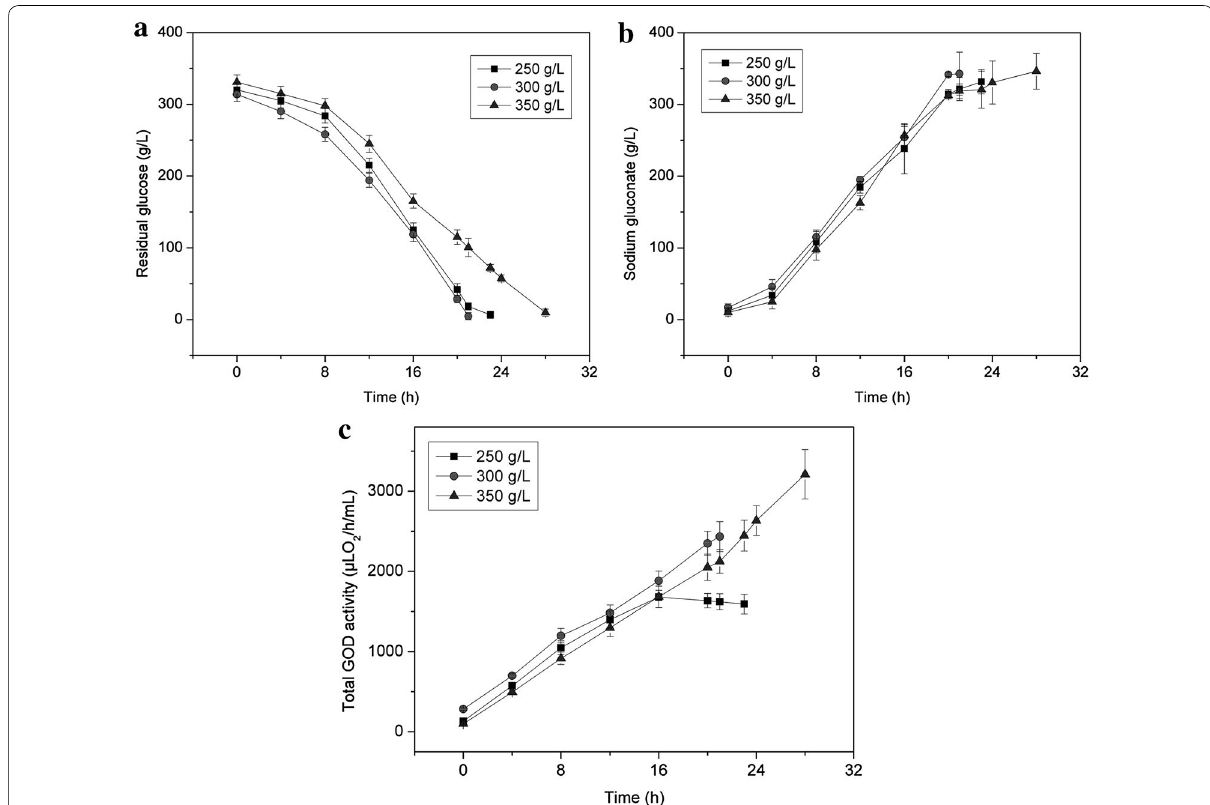
Fig. 9 Time courses of glucose consumption ( a ), sodium gluconate production ( b ), and total GOD activity ( c ) in fermentation processes with differ- ent seed cultures of A.